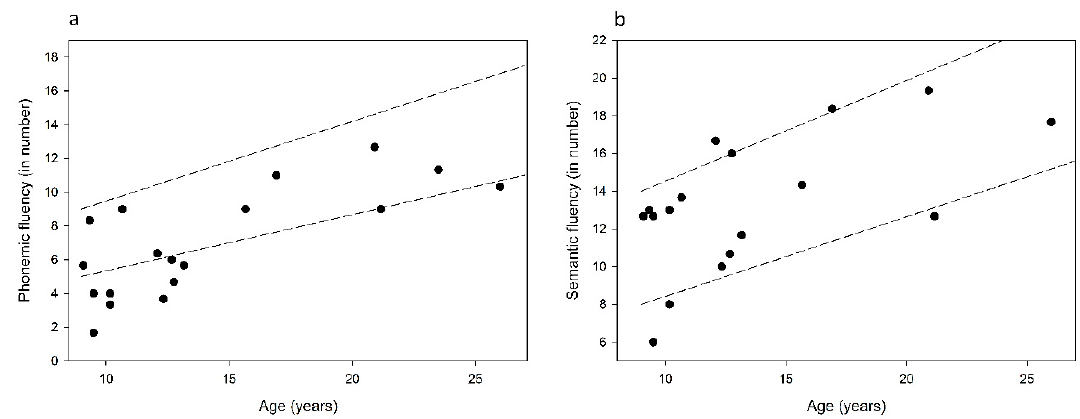
Figure 5. Individual scores in the ( a ) phonemic and ( b ) semantic fluency tests for the Q50 performers (CI users who scored ≥ 50% in the words-in-quiet test) compared to NH performance (shown between the broken lines: mean ± Standard deviation by age) from Kave and Knafo-Noam [72].